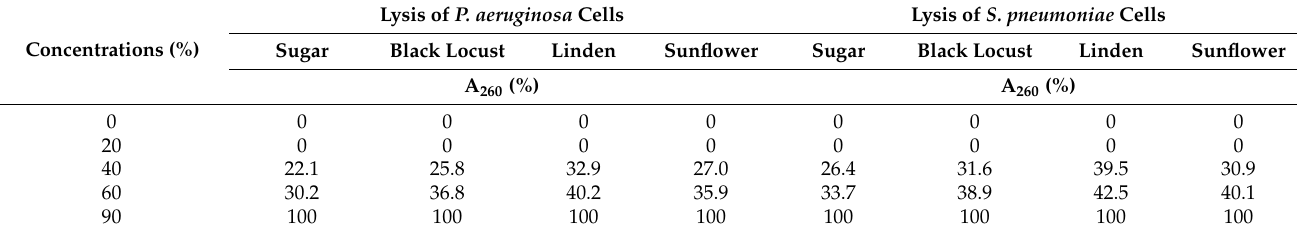
Table 4. The effect of sugar and honey solutions at different concentrations on the release of cellular material, absorbing at 260 nm, from P. aeruginosa and S. pneumoniae . The degree of bacteriolysis was expressed in percentage compared to the control.